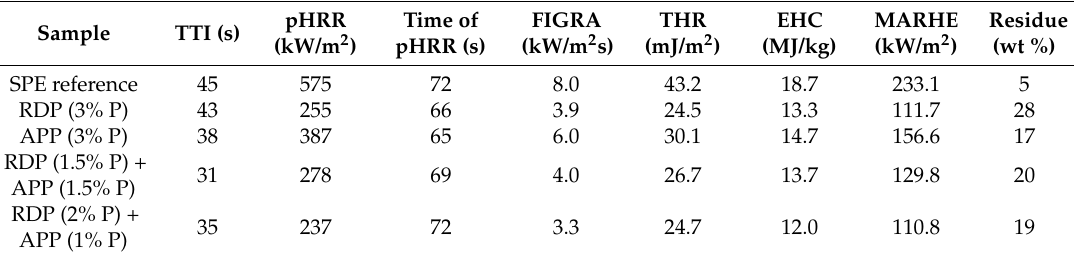
Figure 3. Average temperatures below the reference and flame-retarded SPE samples during mass loss calorimetry tests. Table 3. Mass loss type cone calorimetry results of reference and flame-retarded SPE samples.